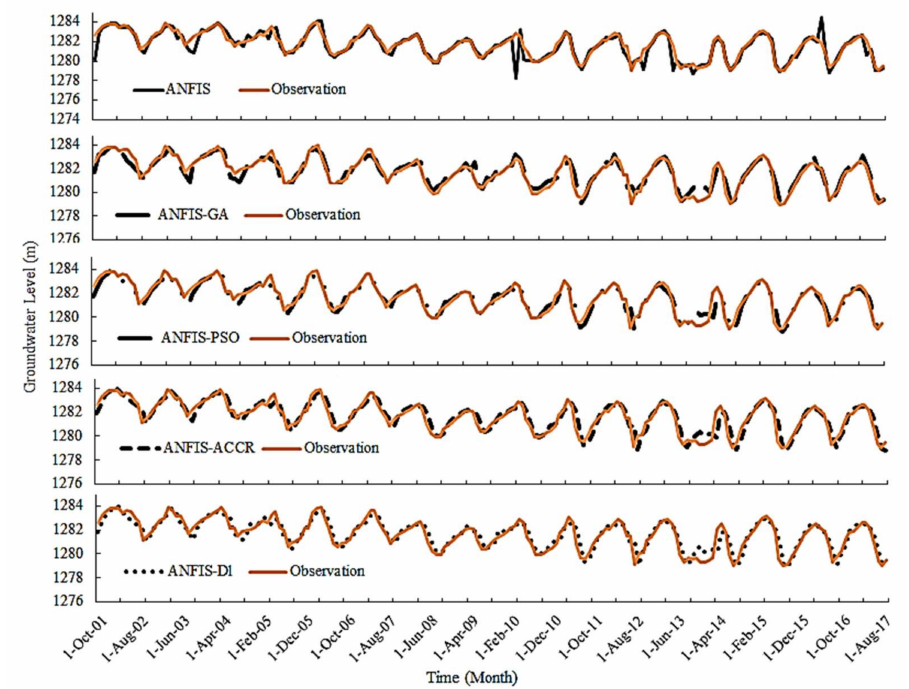
Figure 8. Observations and predictions for well